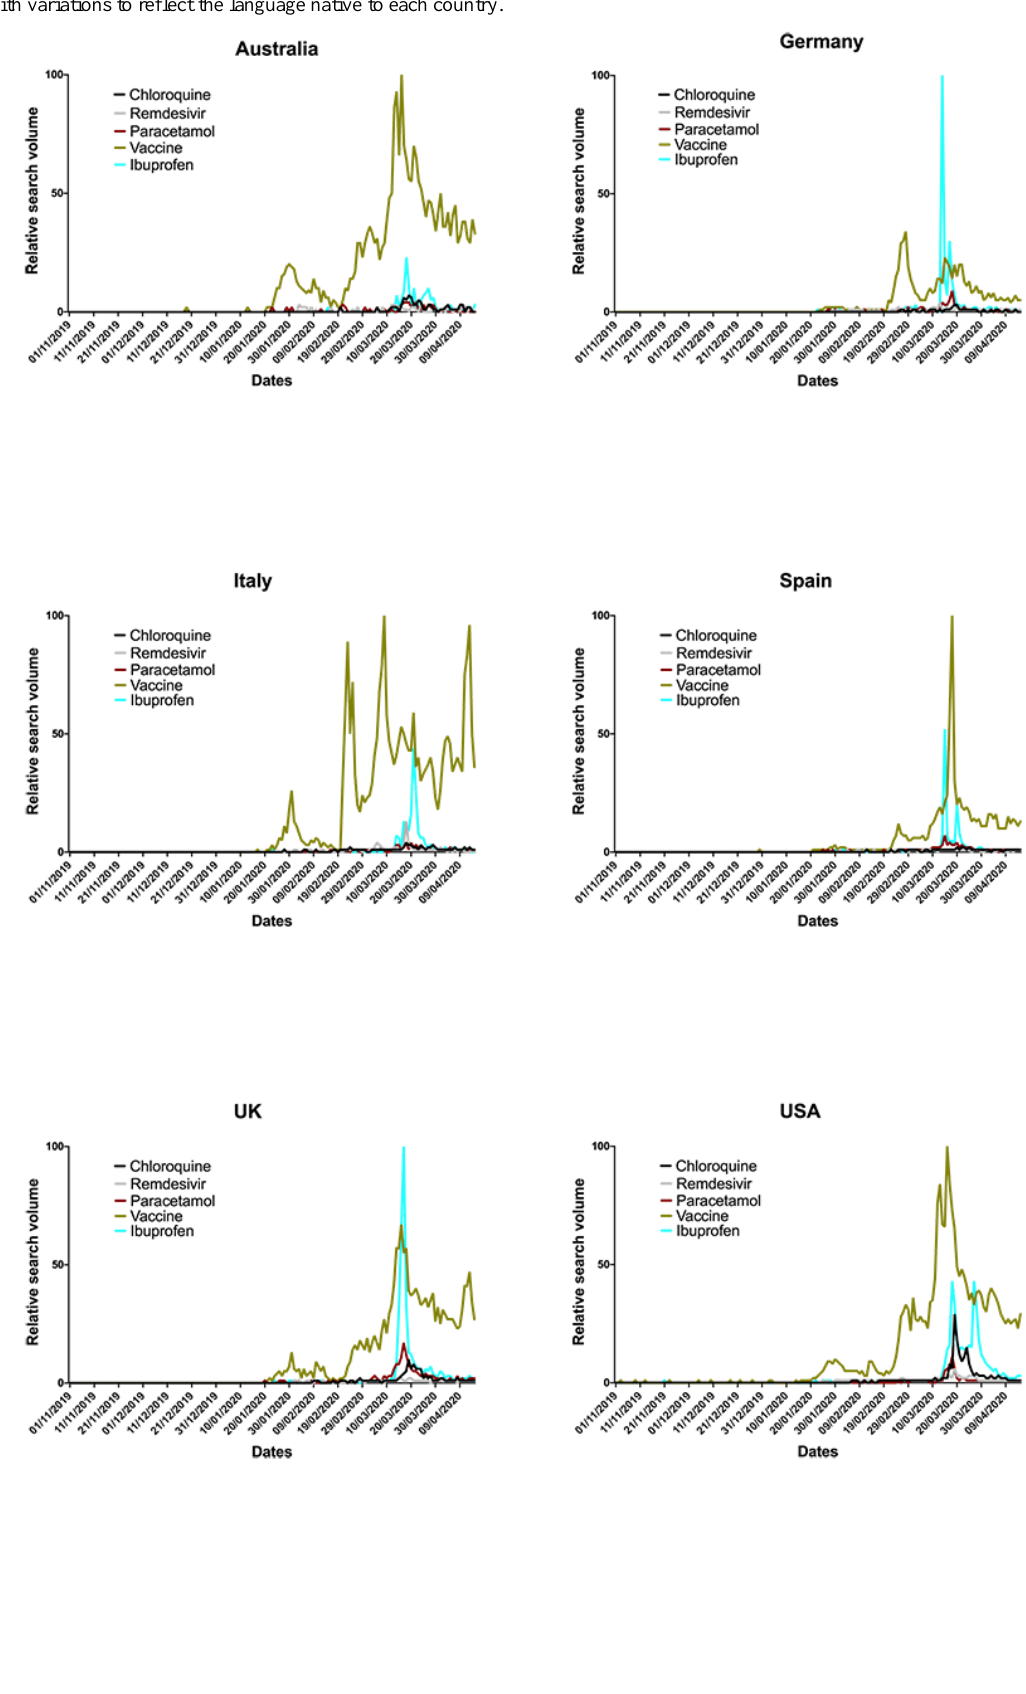
Figure 6. Medical intervention relative search volumes (RSVs) extracted from Google Trends (GT). Grouped RSV data, normalized to the highest RSV peak in the time period (represented as 100) were extracted from GT on April 17, 2020, for the period of November 1, 2019, to April 17, 2020. Search terms included “coronavirus chloroquine,” “coronavirus remdesivir,” “coronavirus paracetamol,” “coronavirus vaccine,” and “coronavirus ibuprofen,” with variations to reflect the language native to each